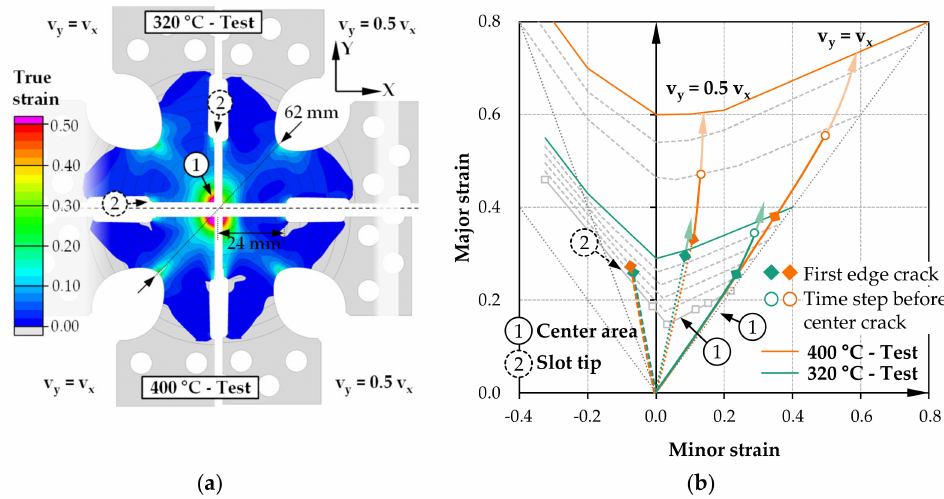
Figure 11. Simulation results of biaxial testing specimen F for 400 and 320 ◦ C test: ( a ) plastic strain distribution immediately before center crack for two loading speed conditions; ( b ) forming limit diagram with strain paths of center and slot tip